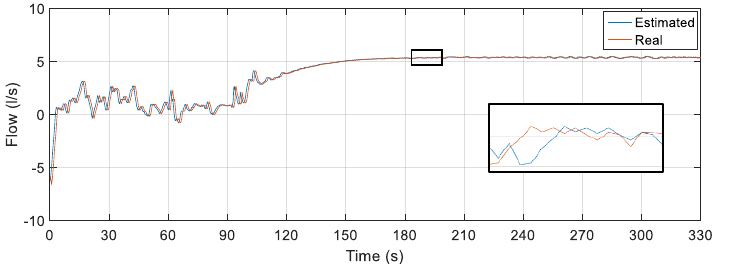
Figure 22. Estimated versus actual flow rate for inserting noise into the three soft sensor inputs.